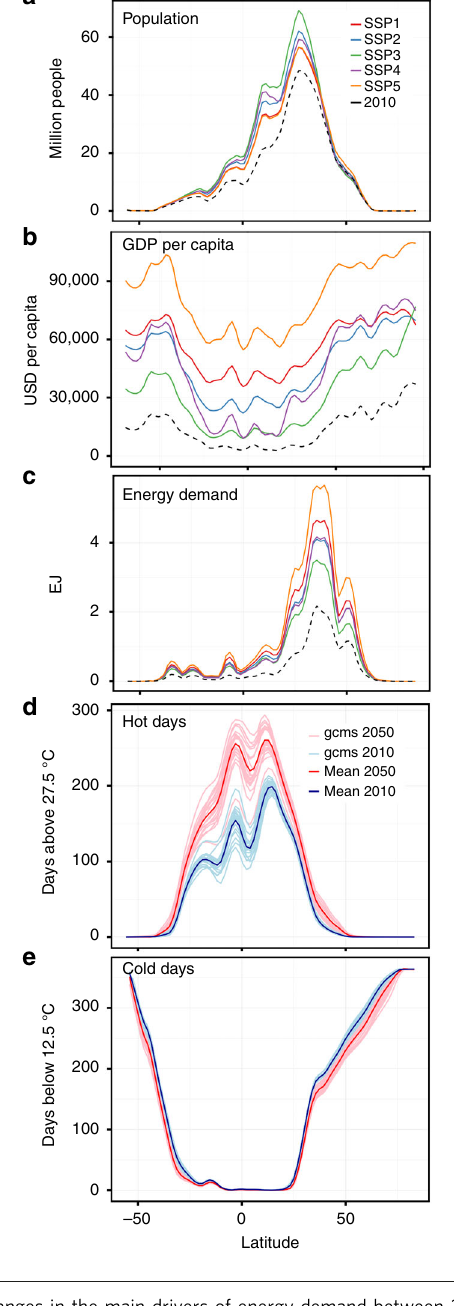
Fig. 1 Changes in the main drivers of energy demand between 2010 and 2050. The data are smoothed and summarized by latitude: population ( a ), GDP per capita ( b ), baseline projections of the total climate-related fi nal energy demand without climate-change impacts as a result of combining our elasticities with GDP and population projections ( c ) number of days with daily average temperature above 27.5 °C ( d ), number of days with daily average temperature below 12.5 °C ( e ) under RCP 8.5. Supplementary Fig. 6 provides a version of this fi gure for RCP